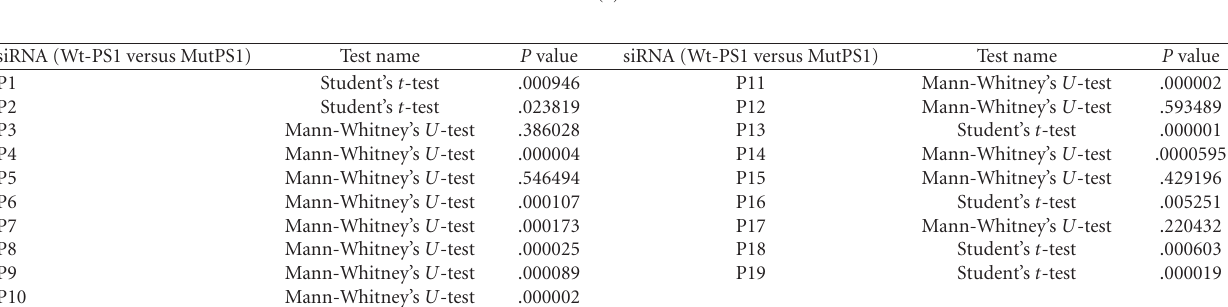
Figure 4: (a) Comparison of the fluorescence level obtained from analysis of HeLa cells cotransfected with pEGFP-Wt-PSEN1(400) or pEGFP-Mut-PSEN1(400), pDsRRed-N1 and indicated siRNAs (0—control nonsilencing siRNA and siRNAs targeting the mutated form of PSEN1 transcript (denoted as P1–P19) (1nM). Dotted lines at the right panel represent the antisense strands of the used siRNAs. Positions of the C:C mismatch between the guide strand of siRNA and the wild-type PSEN1 mRNA are indicated by the black dots. The level of the relative EGFP/RFP fluorescence of the cells transfected with control non-silencig siRNA was used as 100%. The results are mean values from three independent experiments. (b) Statistical analysis of di ff erences between two groups of data (Wt-PSEN1 versus Mut-PSEN1) calculated by the use the Student’s t -test (for data with normal distribution) or by the nonparametric Mann-Whitney’s U -test. The di ff erences with P < . 05 were considered as statistically